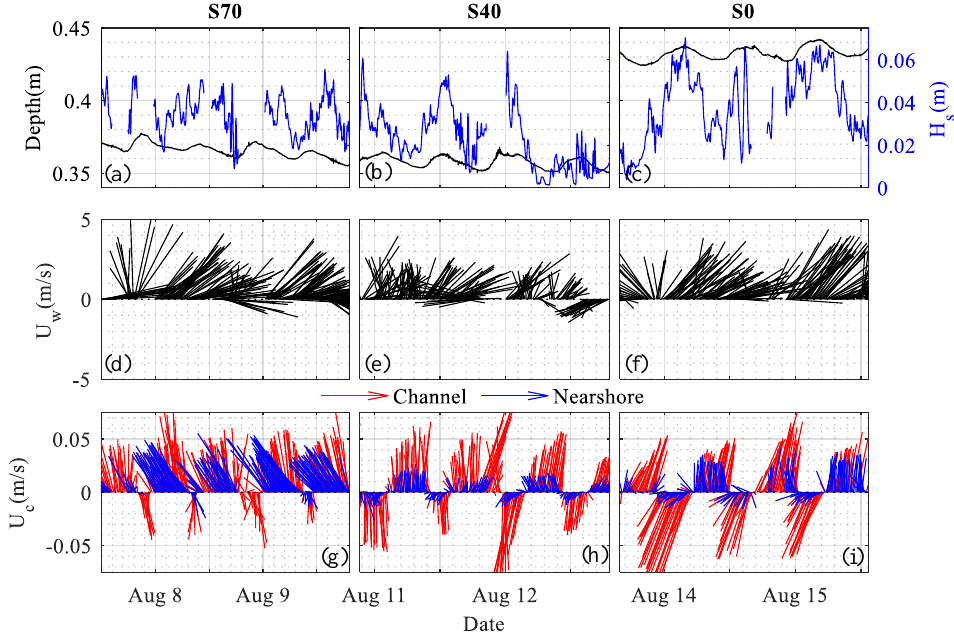
Figure 2. Overview of water depths (black line; a – c ), wave heights (blue line; a – c ), wind speeds ( d – f ), and current speeds (blue: nearshore and red: channel; g – i ) observed over each deployment in 2019. Wind and current speeds are displayed as quiver plots, with the length of the line representing the measurement magnitude and the direction of the line indicating the flow direction referenced to the local definition of channelwise (U) and cross-shore (V) flow (see Figure 1). Water depths were measured nearshore in the vicinity of the Vectrino Profiler.